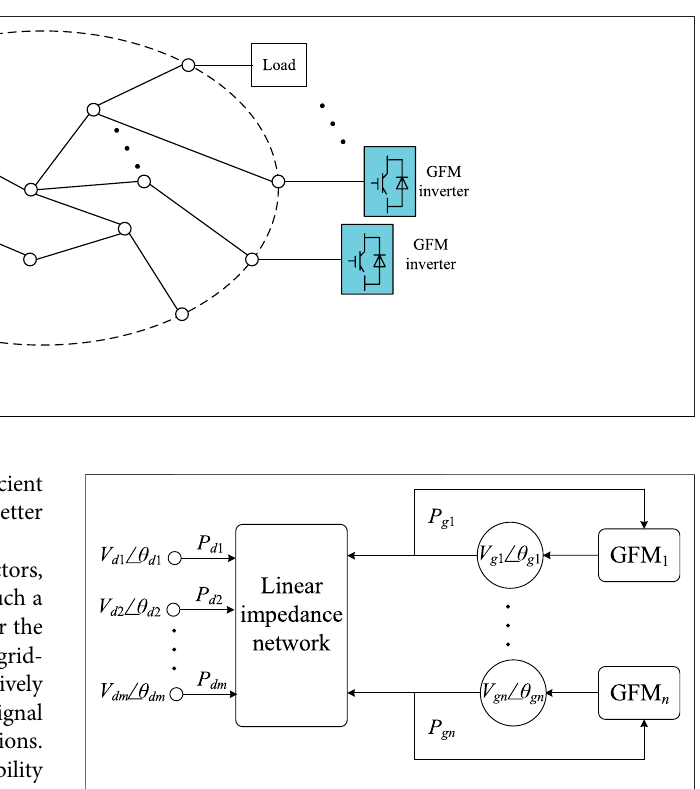
FIGURE 2 | Diagram of the inverter-based power